Question: Based on the figure, does the quantity rise or fall?
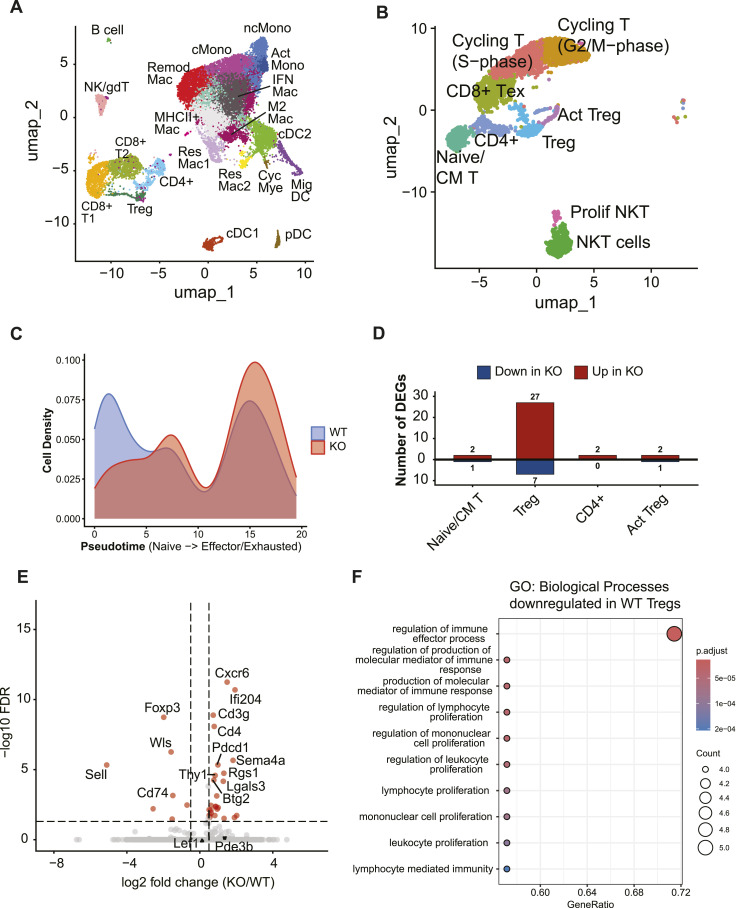
Answer: increasing